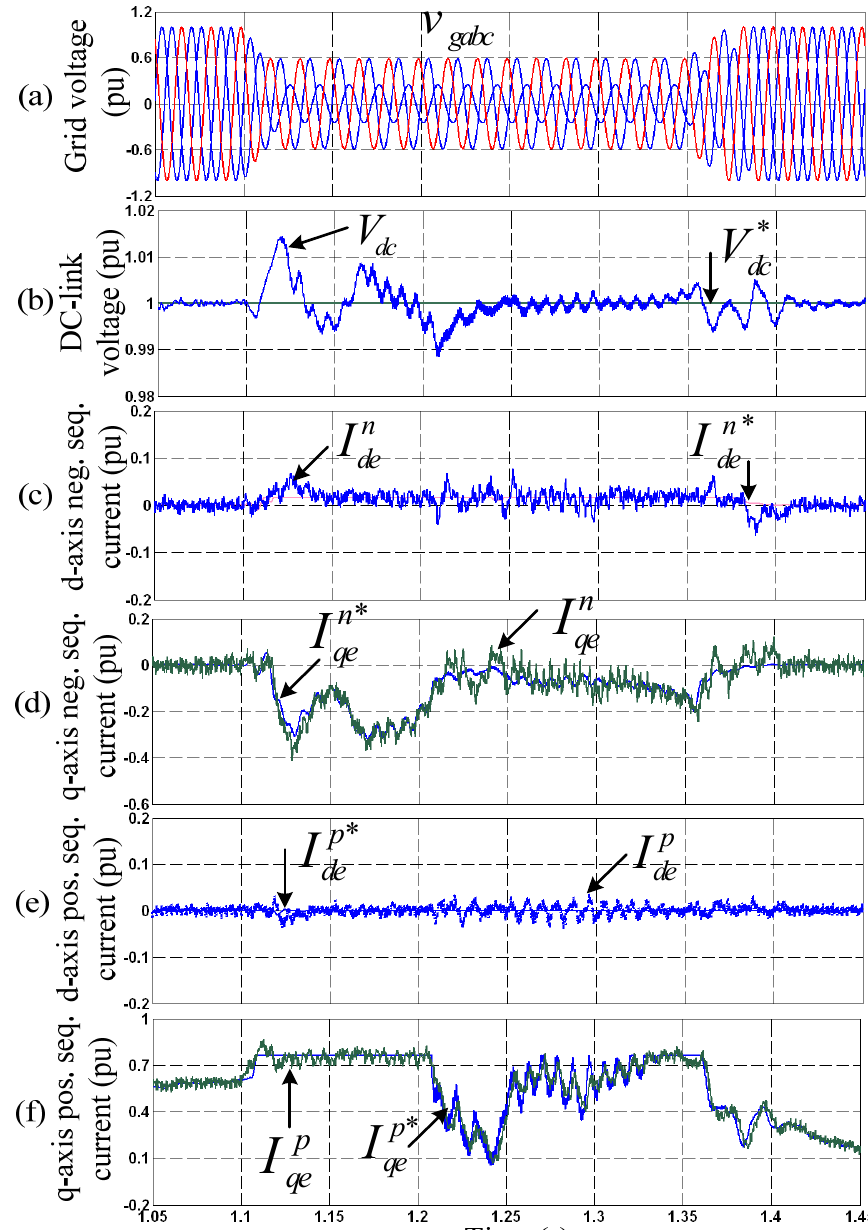
Figure 5. GSC performance at unbalanced voltage dip. ( a ) Grid phase voltages. ( b ) The DC-link voltage of B2B converters. ( c ) NSC d-axis currents. ( d ) NSC q-axis currents. ( e ) PSC d-axis currents. ( f ) PSC q-axis currents.